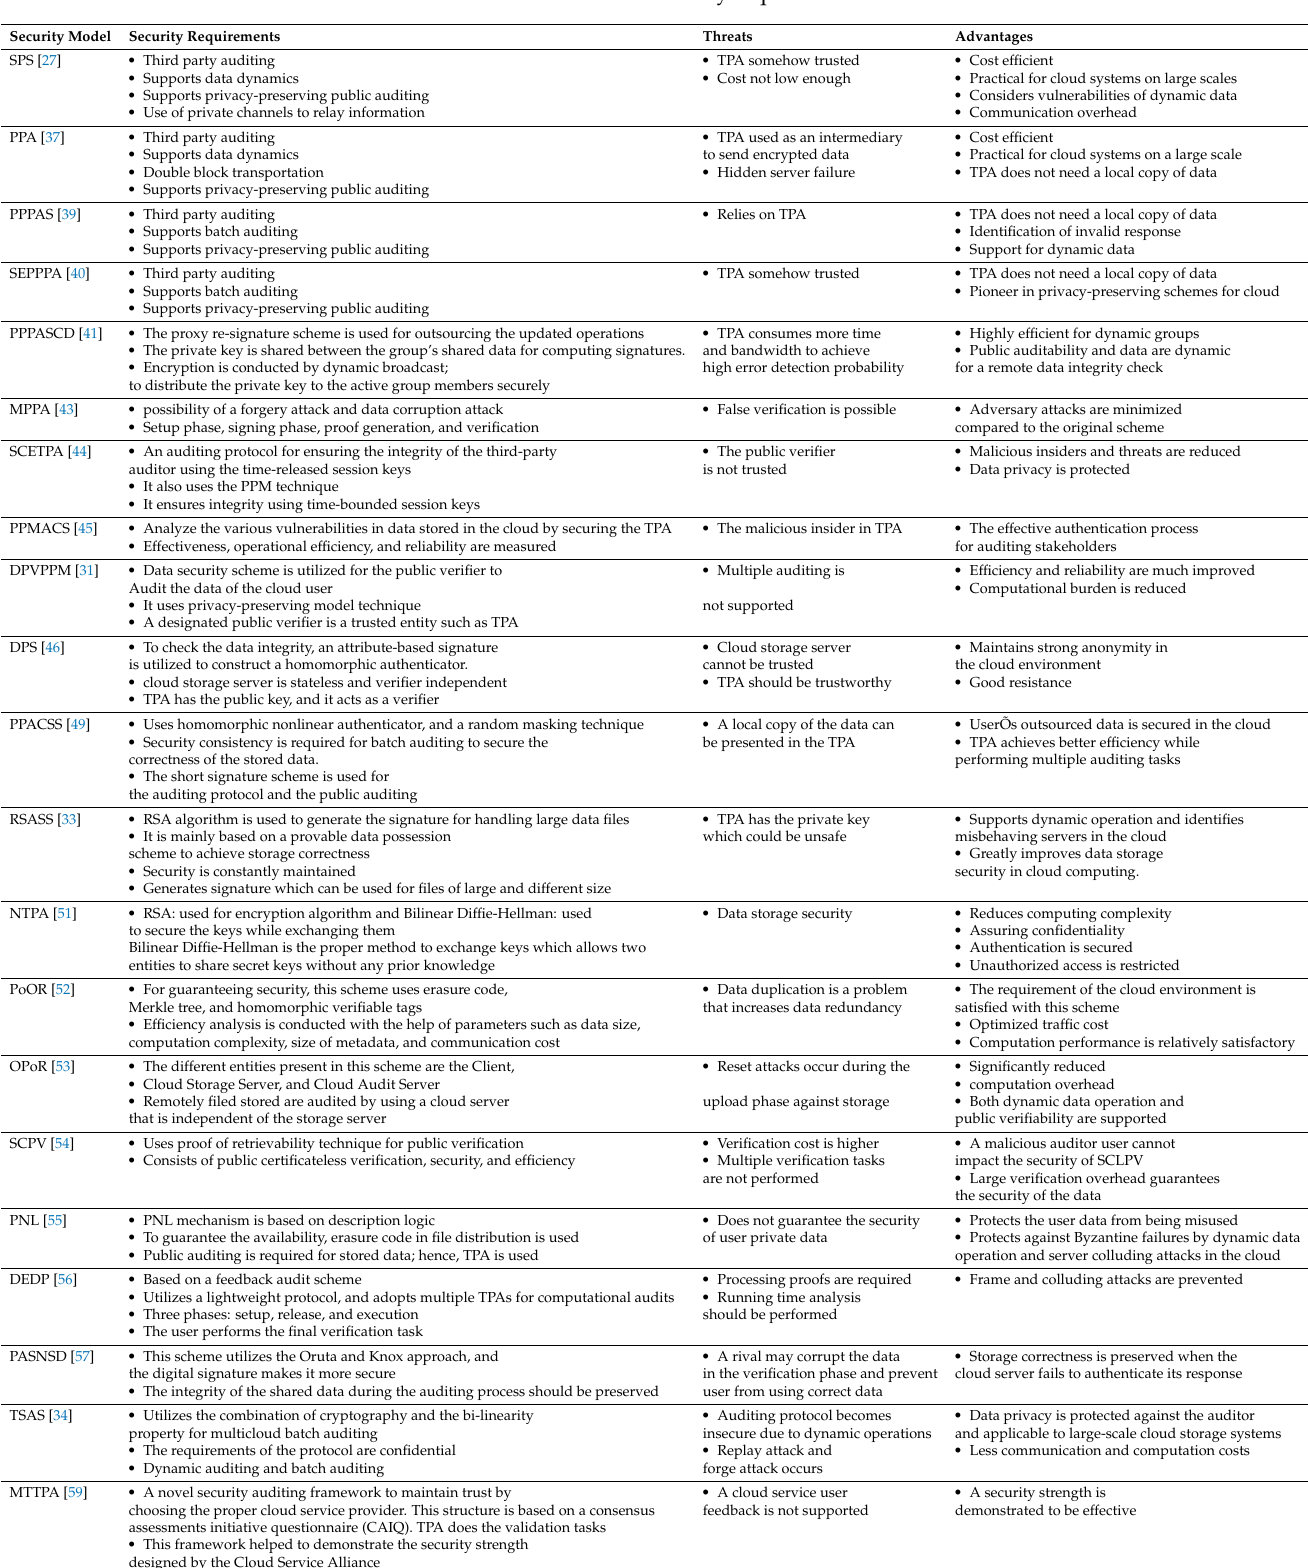
Table 3. TPA classification by